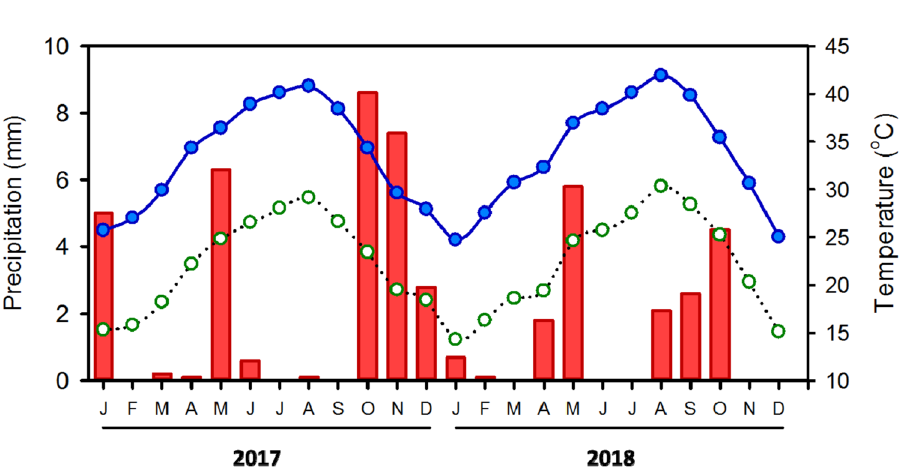
Figure 2. Monthly rainfall (mm; bars) and maximum (solid black circle) and minimum (open circle) temperature (°C) at wadi Rahaba and wadi Khoda, Gebel Elba National Park, south-eastern Egypt from